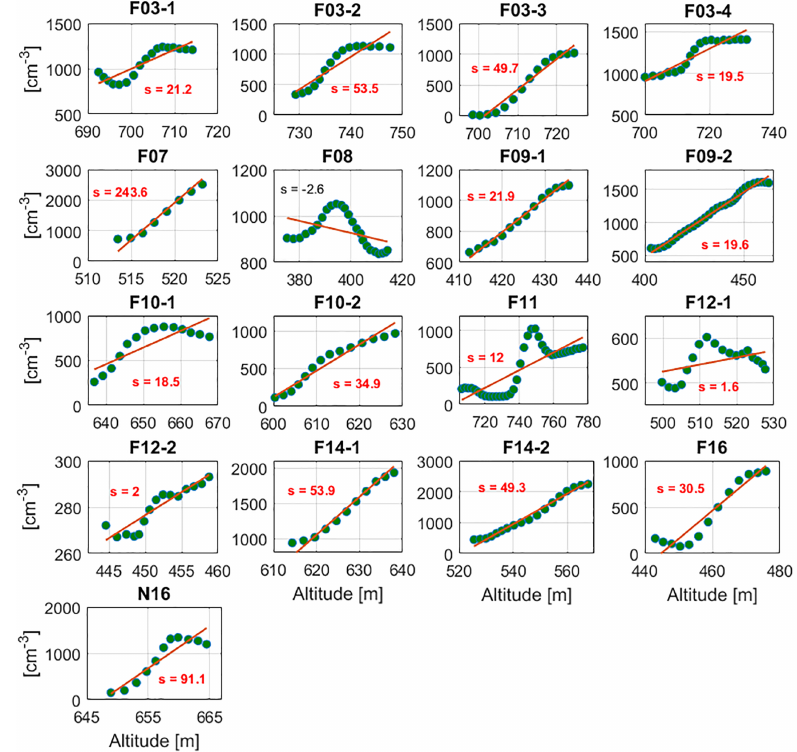
Figure 6. Same as Fig. 5 but for particle concentration in diameter range 10–110nm (i.e.,